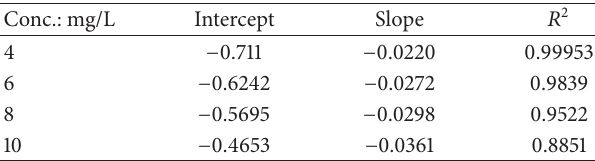
Figure 7: Effect of adsorption dose on MB adsorption on C. polygonoides ash. Table 4: Pseudo-first-order kinetics data for adsorption of MB on C. polygonoides ash.